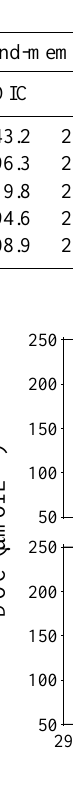
Table 1. River, nearshore and open ocean end-members used in calculations described in Sect. 2.5. DIC and TA designate dissolved inorganic carbon and total alkalinity, respectively, with nits of µmolkg − 1 .